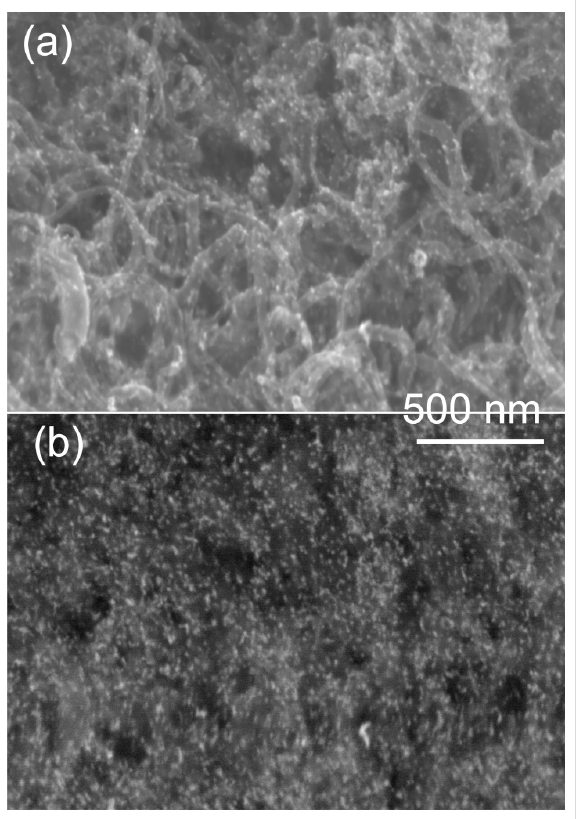
Figure 6: SEM (a) und BSE (b) image of Pt nanoparticles deposited from an aqueous 0.005 M Pt(NO 3 ) 2 and 0.1 M NaNO 3 solution